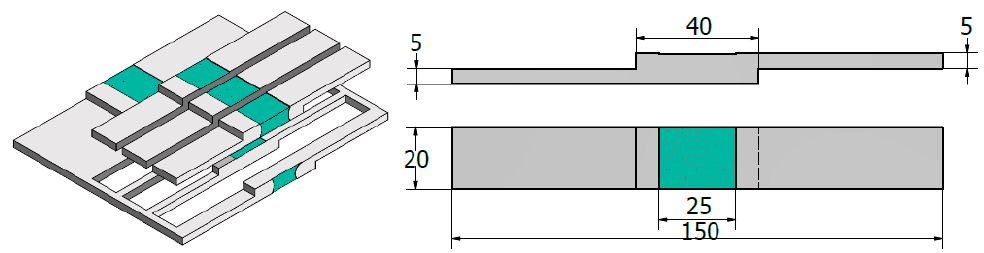
Figure 4. Schematic of the tensile-shear test sample (all dimensions in mm).